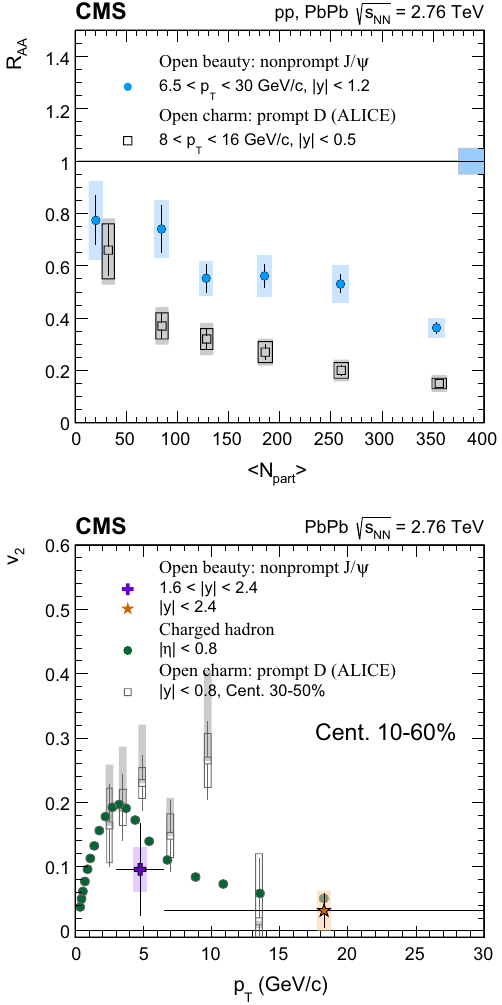
Fig. 10 Nonprompt J /ψ and prompt D meson [31,62], and charged hadron [58,60] R AA vs.centrality ( top ), and v 2 vs. p T ( bottom ). For the top plot, the average N part values correspond to events flatly distributed across centrality